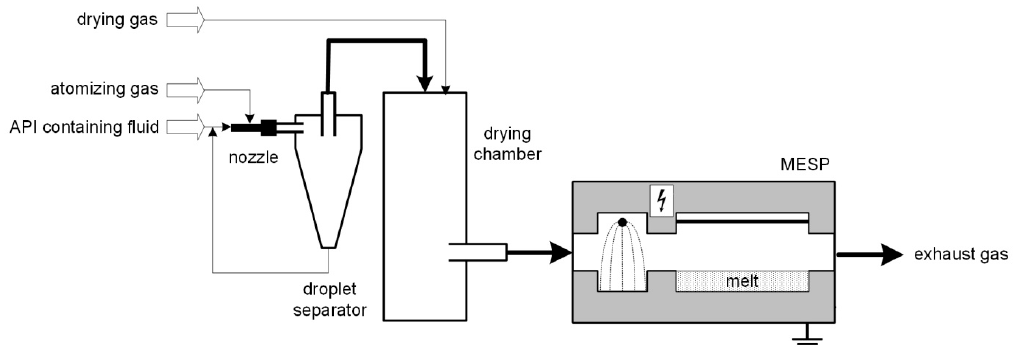
Figure 1. Schematic of the setup for spray drying experiments.